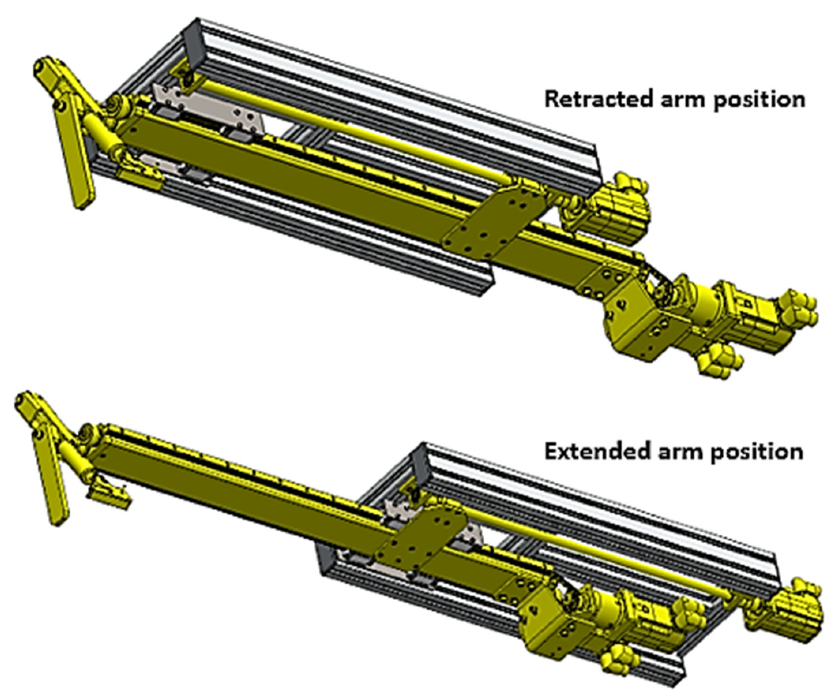
Figure 19. Linear movement of the extensible arm assembly and its dependence.